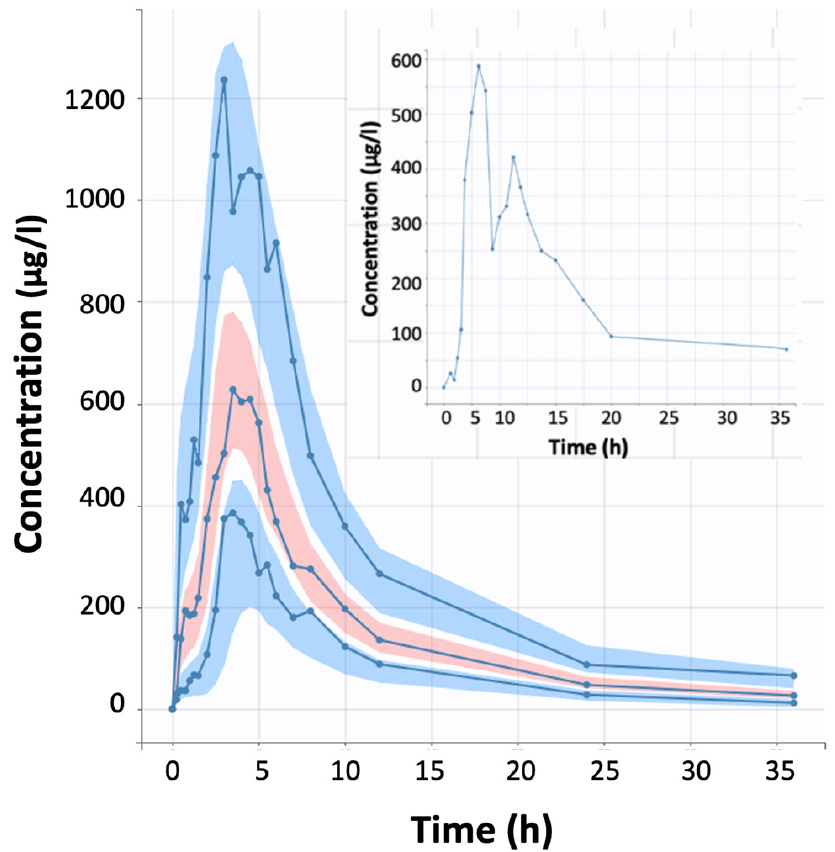
Figure 1. Visual predictive check plot for the final amisulpride model. The blue lines refer to the 10th, 50th, and 90th percentiles of empirical data and the shaded areas refer to the predicted 90% confidence intervals around each zone (10th, 50th, and 90th percentile). A number of 1000 Monte Carlo simulations were performed. The inset shows a spaghetti plot of the observed amisulpride C-t data of one indicative volunteer where the dual peak phenomenon is evident.